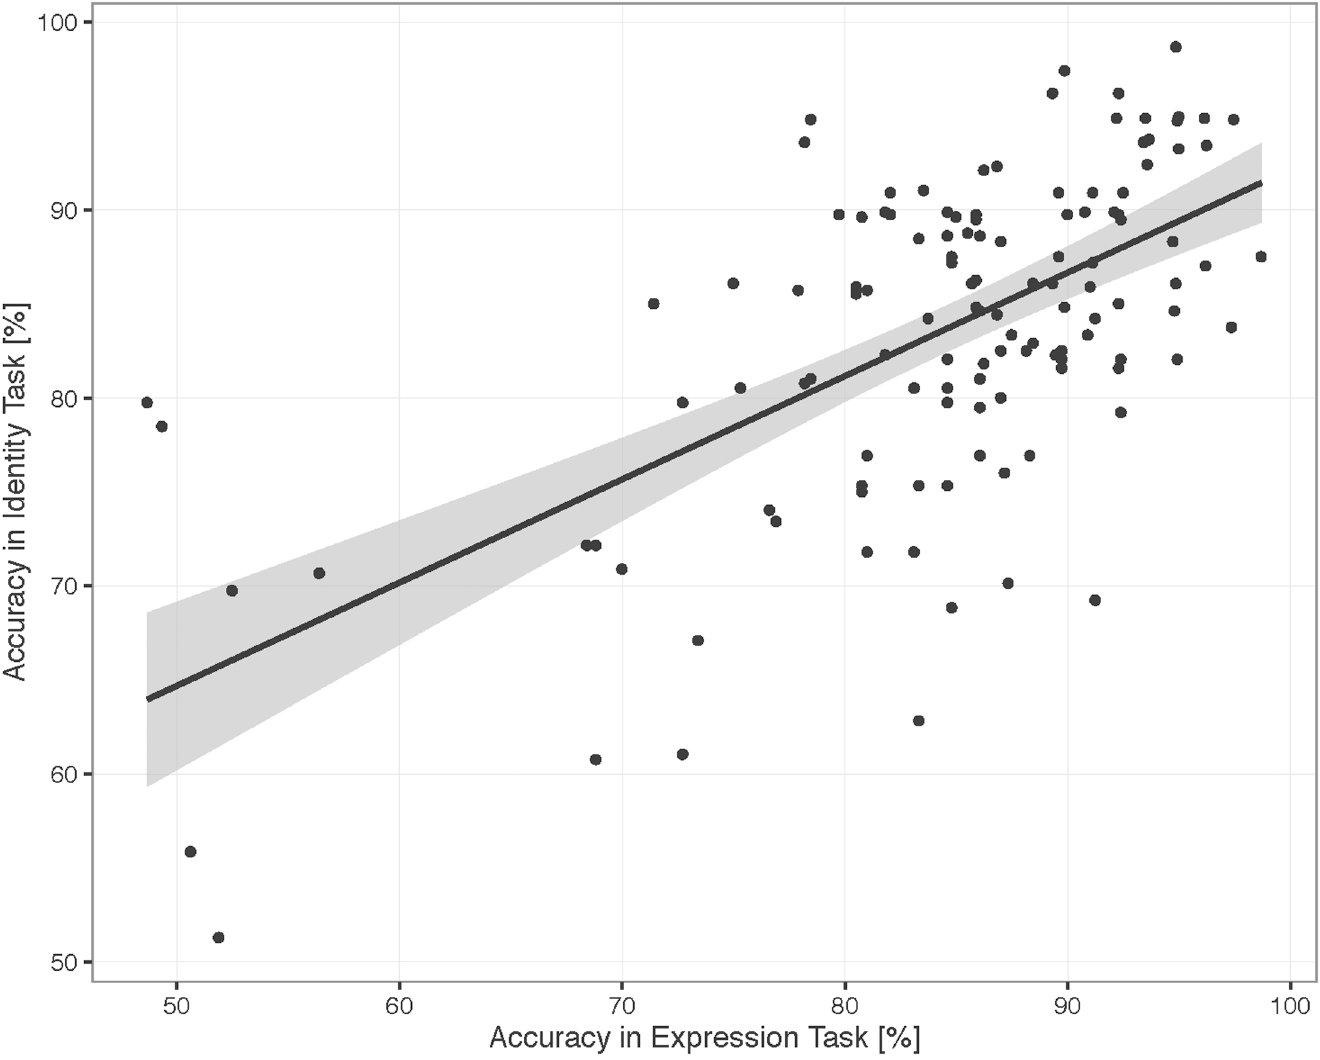
Fig 3. Correlation between identity and expression: Accuracy. Scatterplot illustrating correlationbetweenparticipantaccuracyon identity and expressiontasks, in %. Data includeall trials except those with 50% morphs, which do not have a correct response. Grey shadingindicates95%